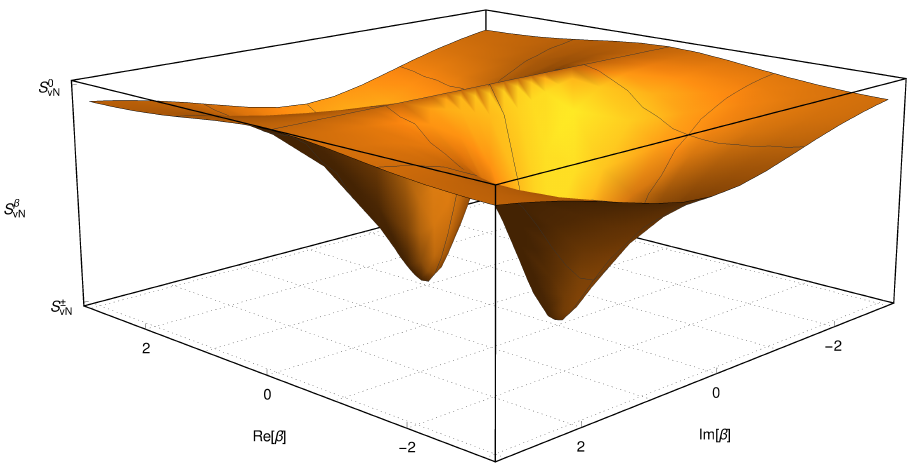
Figure 3: Plot of von Neumann entanglement entropy with respect to β . We already expected that the entanglement to be minimum for the case of β = ± 1 which is apparent in the figure. In the case where β is purely imaginary, we notice that the EE is again maximum and would not change. This figure is valid for a connected subsystem starting from site 0, for a general set of couplings in the Hamiltonian and size of the full system and